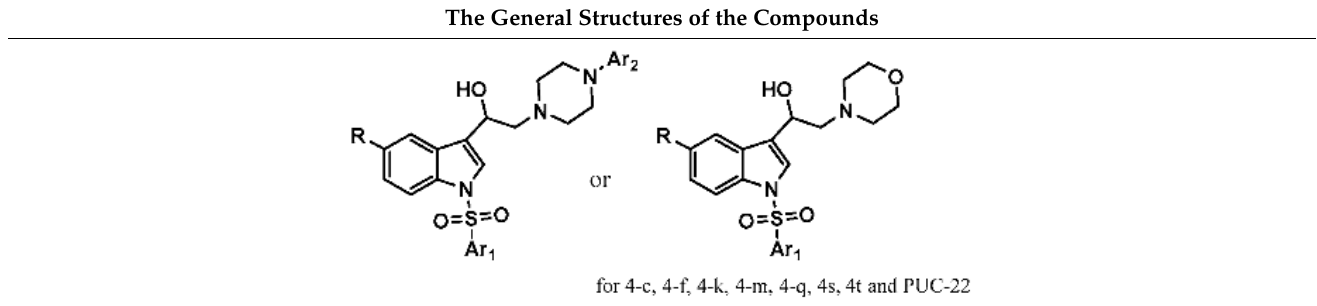
Table 1. 5-HT 6 Binding affinity results for new N -arylsulfonylindole derivatives. The General Structures of the Compounds